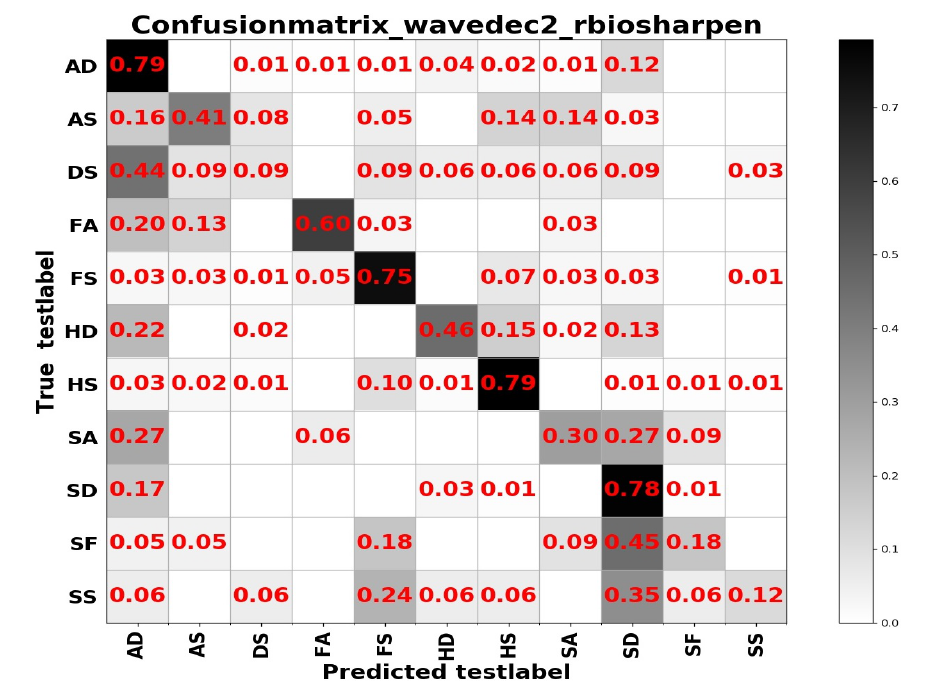
Figure 11. The confusion matrix of the RAF Compound test based on the input channels composed of the combination of spatial and frequency domain images under wavelet base rbio3.1.